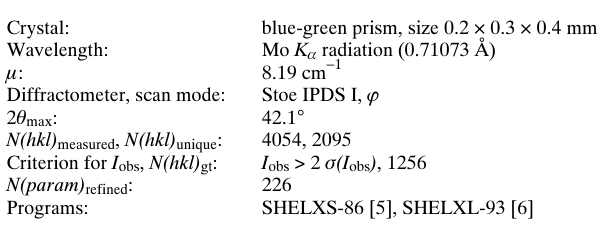
Table 1. Data collection and